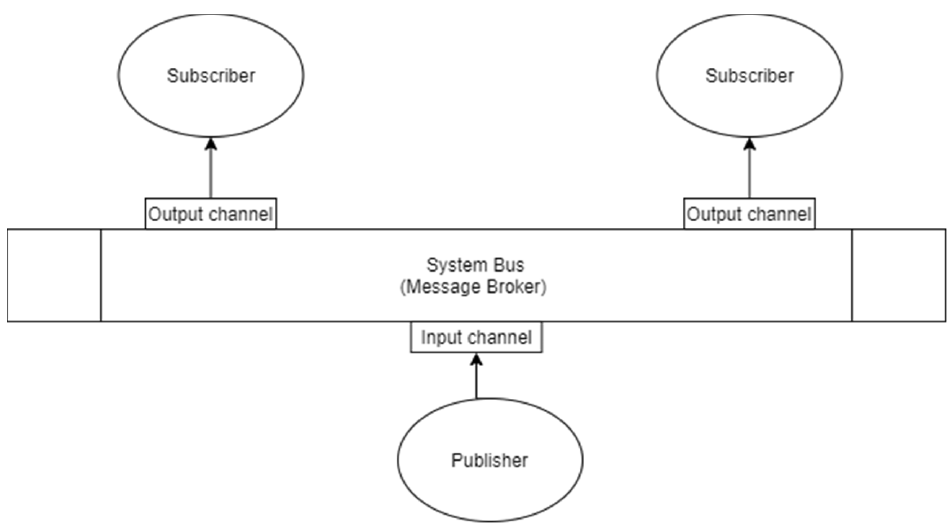
Figure 5. Publisher-subscriber architecture based on asynchronous communication of services inter-platform.